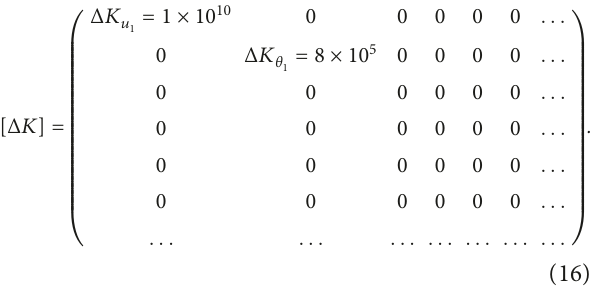
� 1 × 10 10 Nm). ( Δ K u θ 1